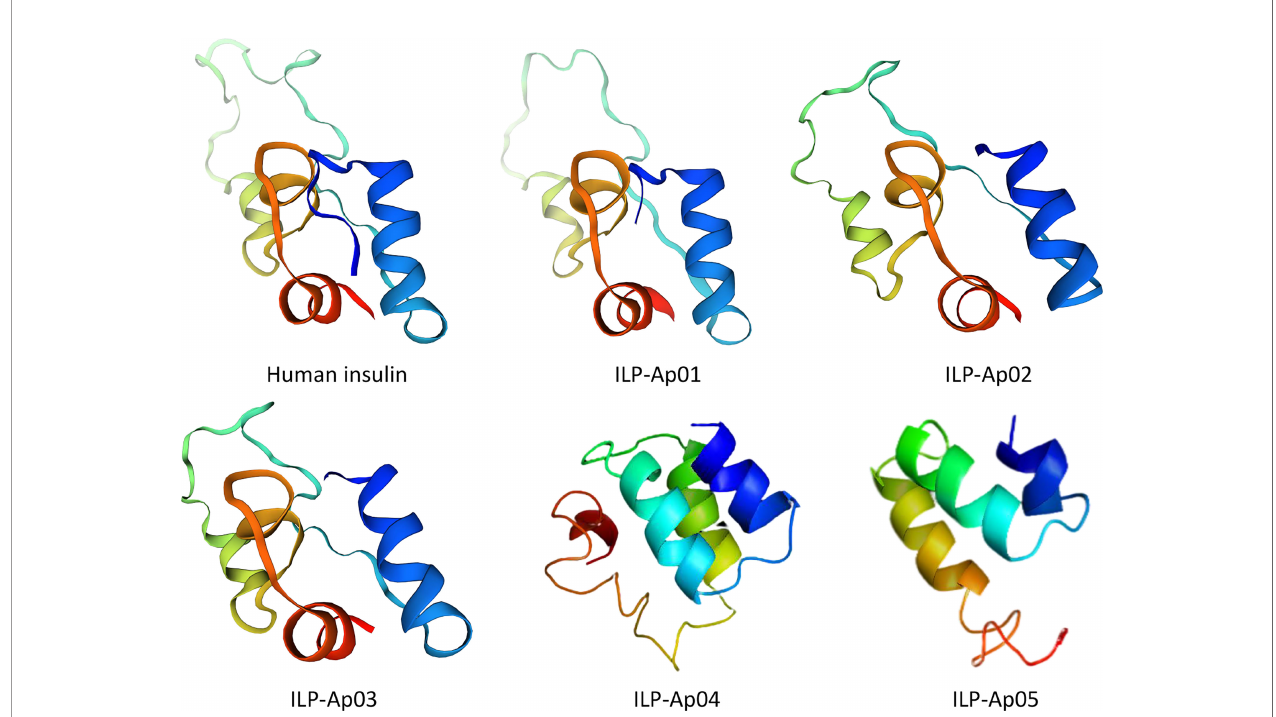
FIGURE 9 | Comparisons of tertiary structures for human insulin with predicted 3D models for ILPs from Exaiptasia diaphana . 3D structure for human pro-insulin was downloaded from Protein Data Bank (PDB ID: 2kqp). The 3 functional helices as well as hydrophobic cores are shown. Colors denote the A chain (blue), the C chain (yellow-cyan) and the B chain (red) for all peptides. All ILP models were predicted without signal peptides or the propeptide before the B